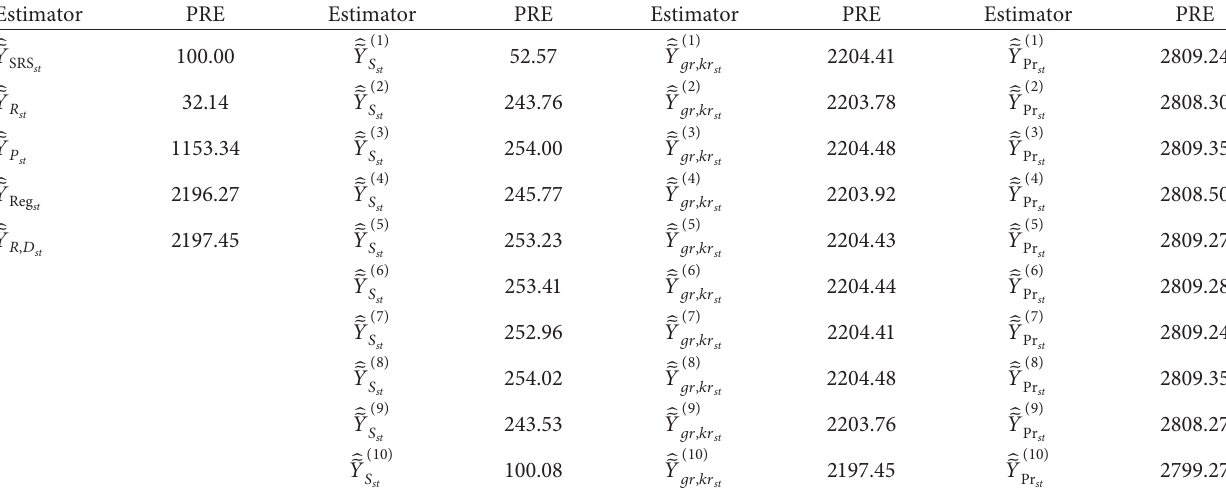
Table 12: PREs of finite population mean estimators using population 1 (scenario